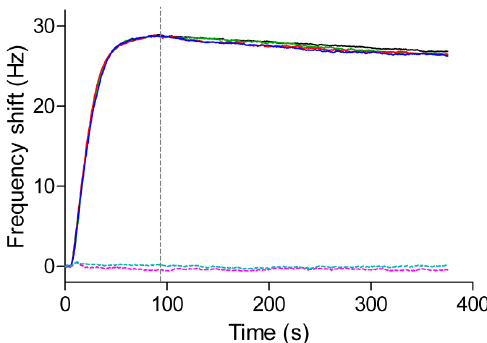
Figure 7. Reproducibility and specificity of the sensor surface. Solid lines: four cycles (black, red, green and blue curves) of the interaction between myoglobin (4 μg/mL) and anti-myoglobin 7005 antibody; Dotted lines: two cycles (teal and magenta curves) of the interaction between BSA (4 μg/mL) and anti-myoglobin 7005 antibody.